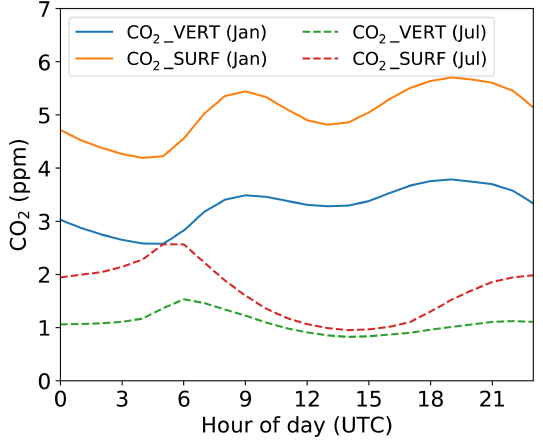
Figure 8. Mean diurnal cycles of the tracers CO2_VERT and CO2_SURF in January and